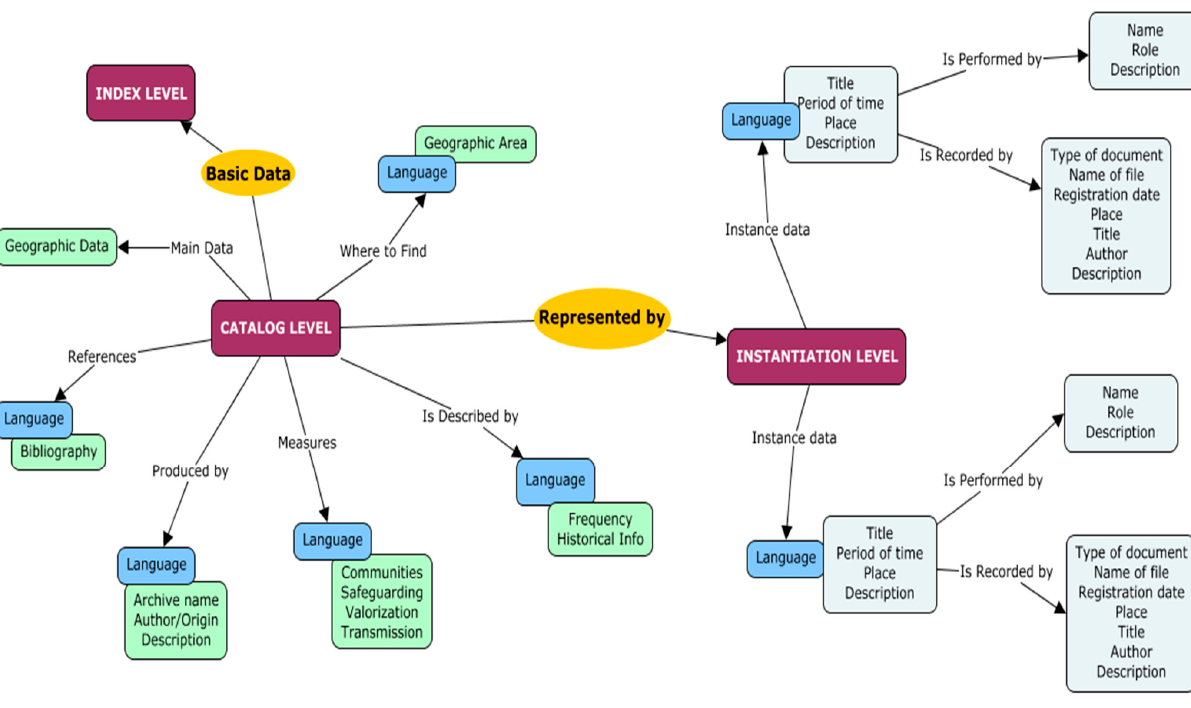
Figure 3. Catalog and instantiation